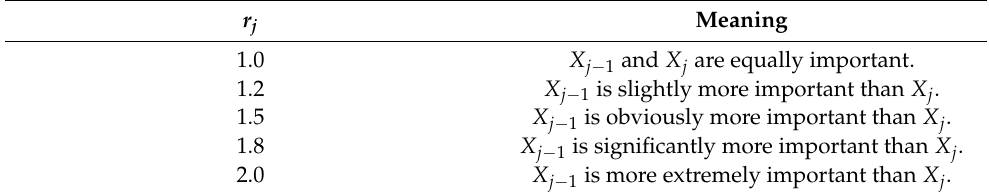
Table 4. Rational assignment of